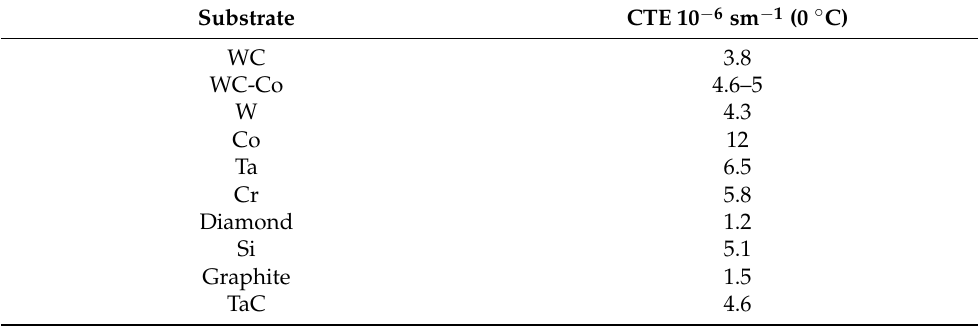
Table 1. Coefficient of thermal expansion values of materials suitable for making the